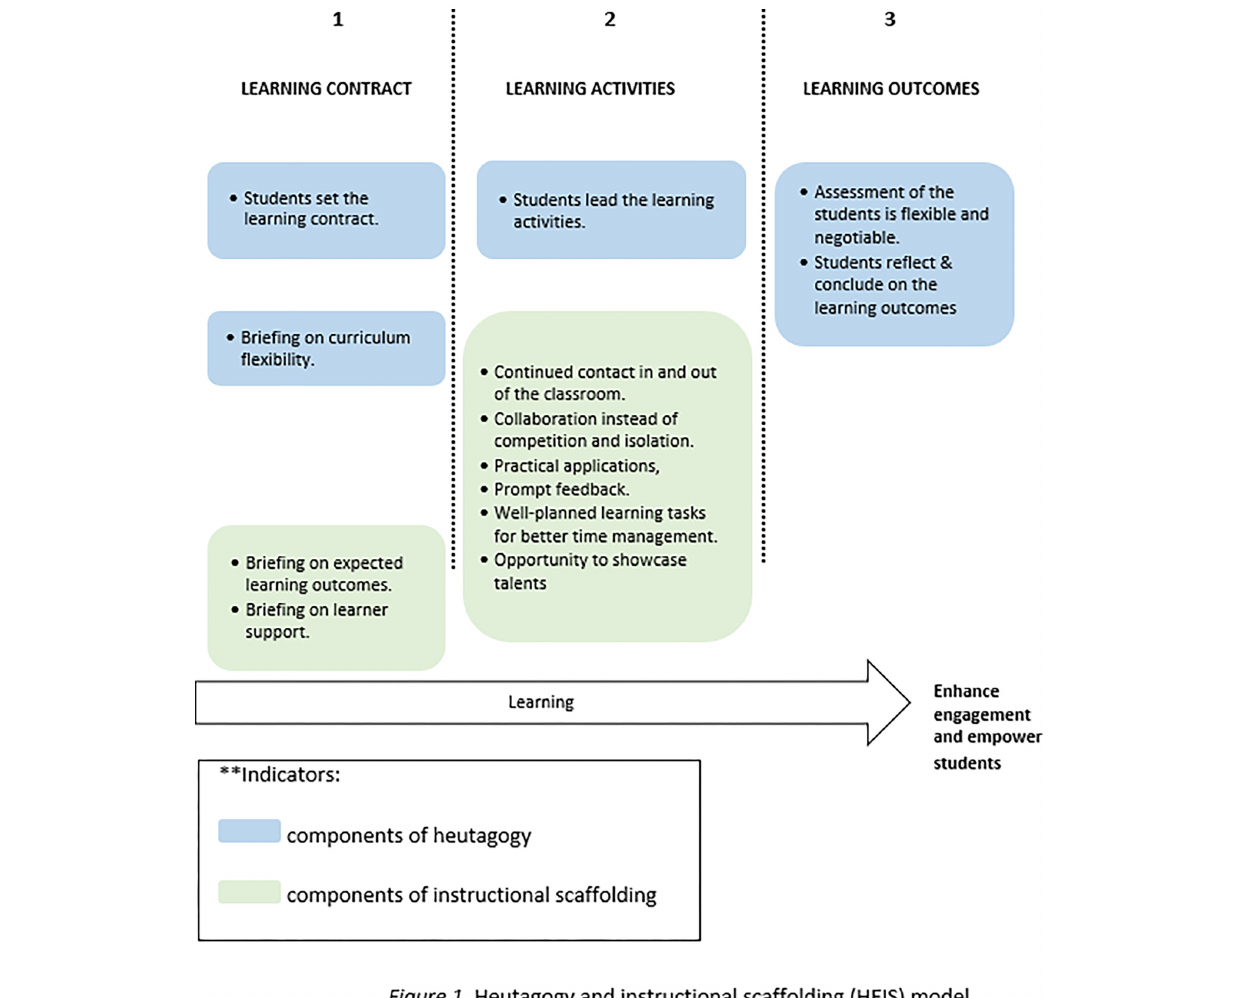
FIGURE 1 | Heutagogy and instructional scaffolding (HEIS)